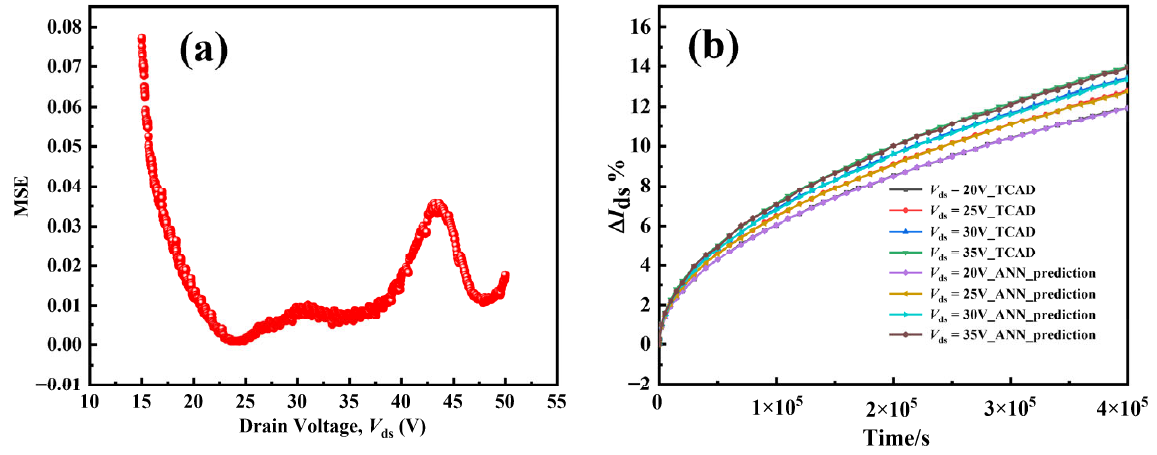
Figure 10. (a) The training MSE of ANN. (b) Comparison of the training data with predicted re ‐ Figure 10. ( a ) The training MSE of ANN. ( b ) Comparison of the training data with predicted sults.